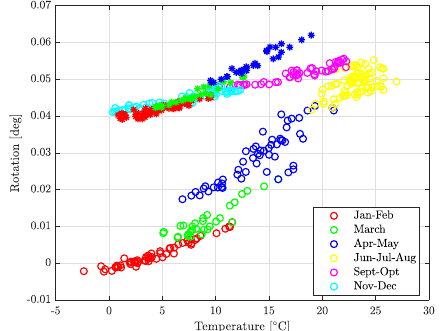
Figure 9. T8 daily average trend (2021–2022) vs.